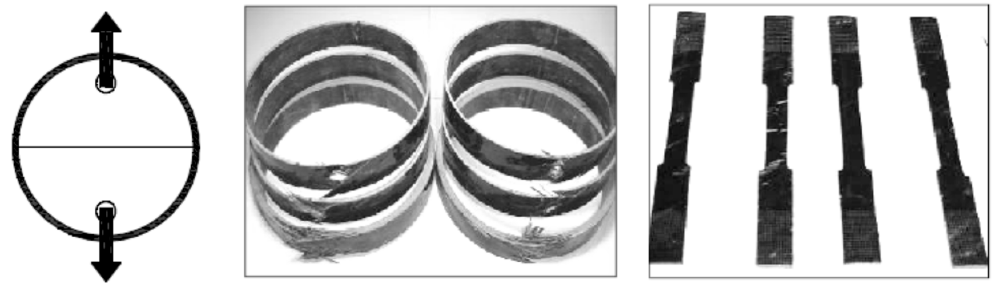
Figure 4. Specimens of FRP tubes for the split-disk test and coupon tensile test [28].